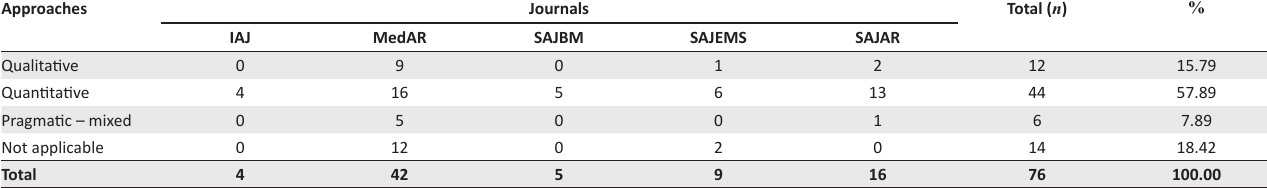
TABLE 7: Research approaches.